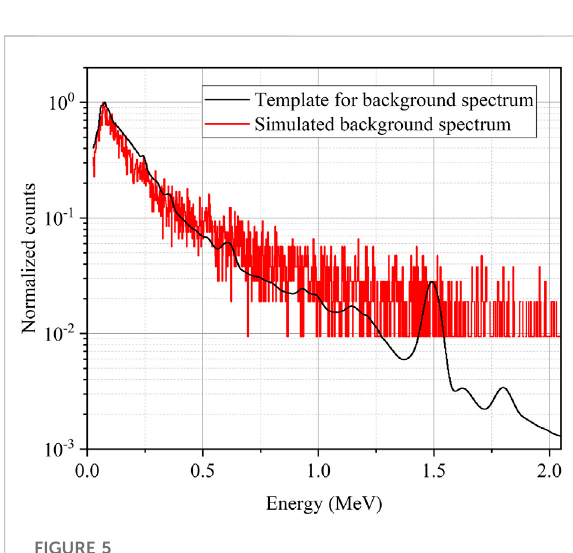
FIGURE 5 Template for sampling simulation and simulated background